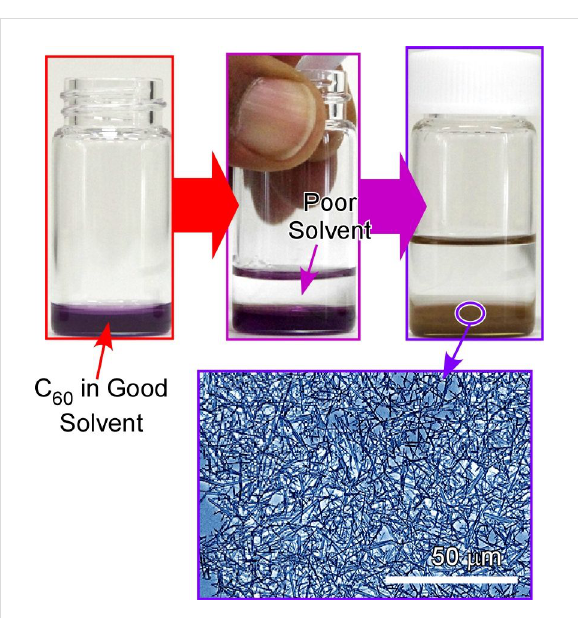
Figure 15: Liquid–liquid interfacial precipitation to fabricate fullerene assemblies (crystals) with various morphologies (in this case, assembly of one-dimensional nanowhiskers). Fullerene molecules, such as C 60 and C 70 , are dissolved in a liquid phase (good solvent) that contacts an immiscible liquid phase in which the molecules are poorly soluble (poor